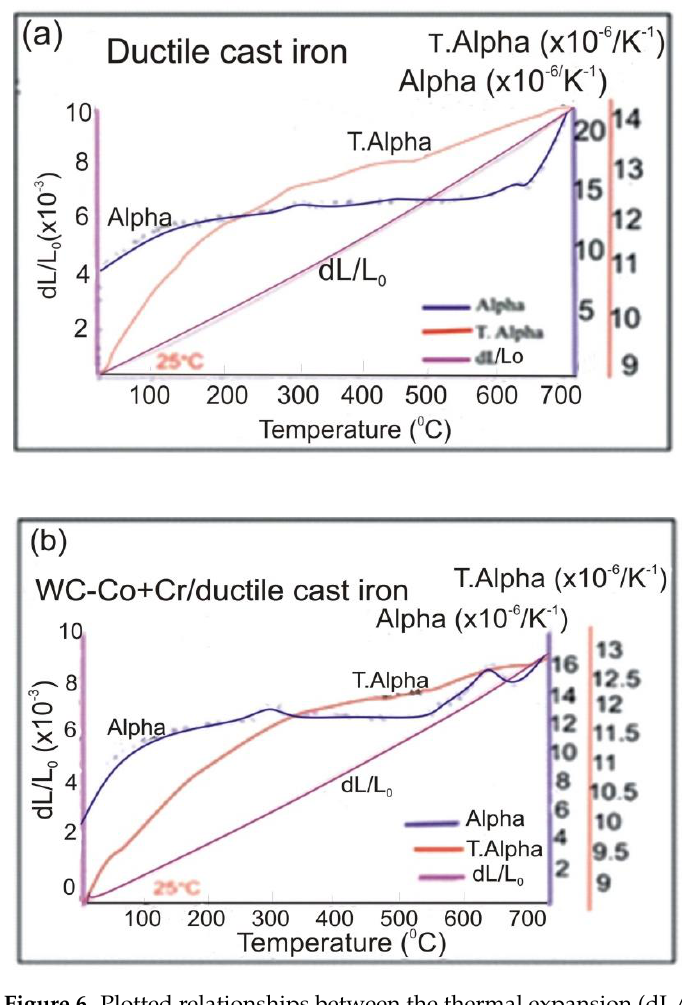
Figure 6. Plotted relationships between the thermal expansion (dL/Lo), the linear thermal expansion coefficient (Alpha), the average thermal expansion coefficient (T.Alpha) and temperature for: ( a ) ductile cast iron and; ( b ) WC–Co + Cr/ductile cast iron.